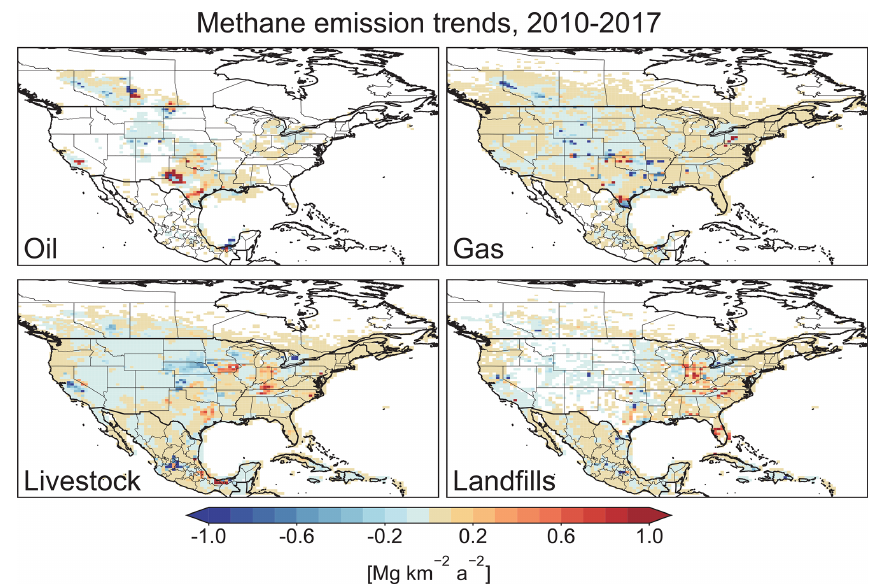
Figure 10. The 2010–2017 linear trends in emissions from major anthropogenic sectors on the 0 . 5 ◦ × 0 . 625 ◦ grid as inferred from the base inversion. The linear trends are fitted by linear regression to the inversion results for individual years. Areas in white have no emissions from the corresponding sector.